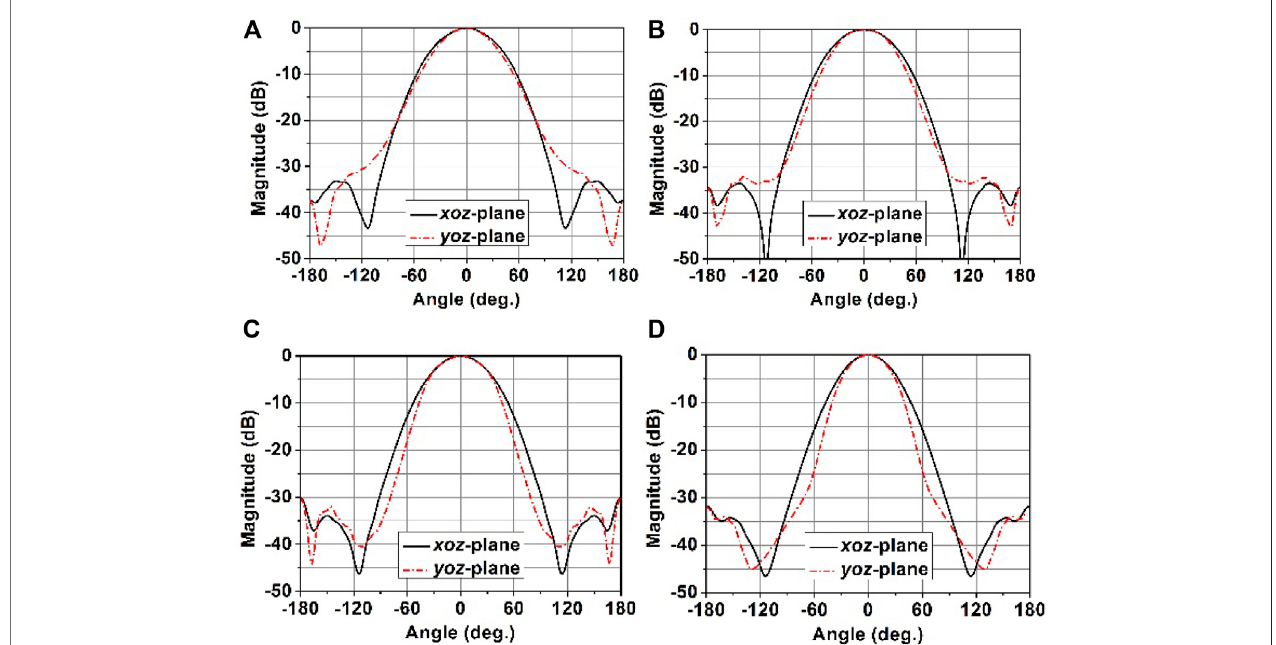
FIGURE 7 | Simulated radiation patterns of the proposed corrugated horn antenna element at (A) 26 GHz. (B) 30 GHz. (C) 35 GHz. (D) 40 GHz. Frontiers in Physics |